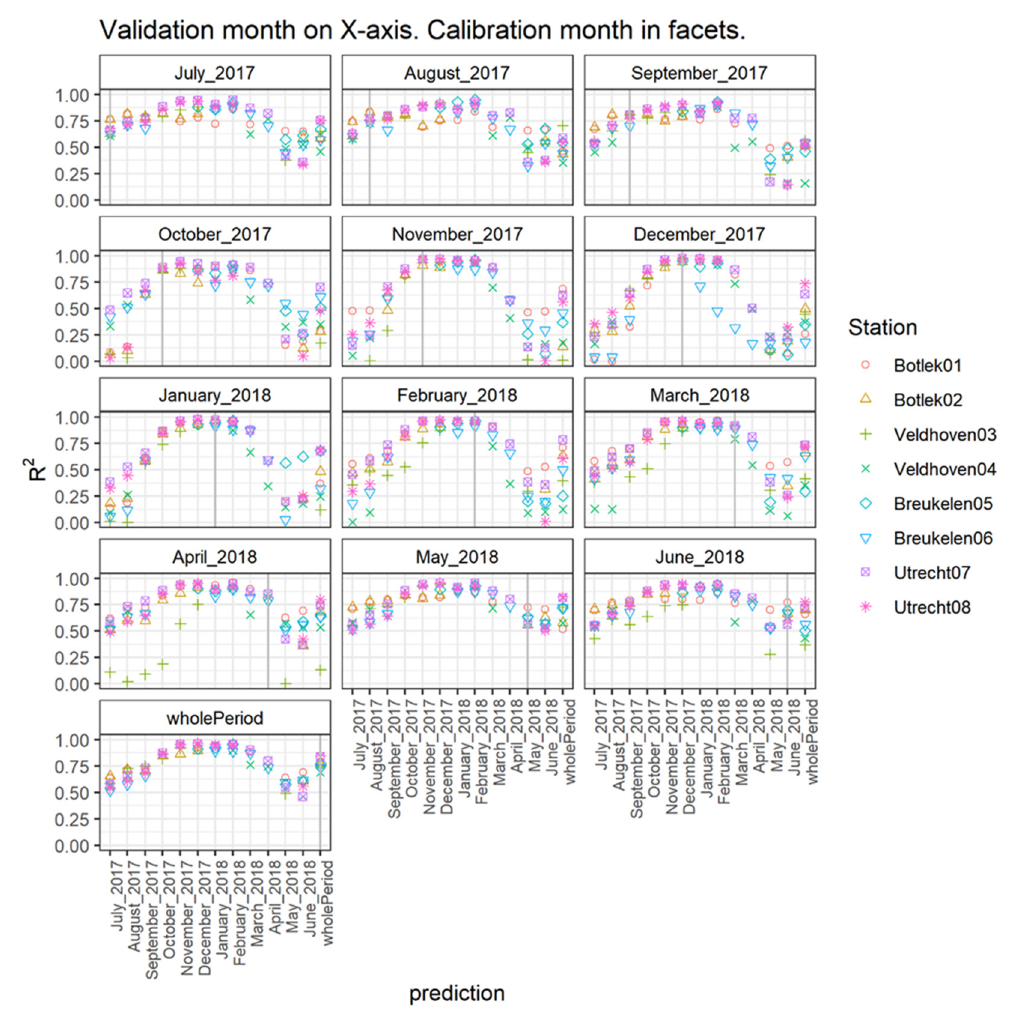
Figure 8. R 2 for model 6 for each combination of calibration and validation period (month or entire year). The month used for calibration is given in the title of the subgraphs. The validation month is given on the X -axis.